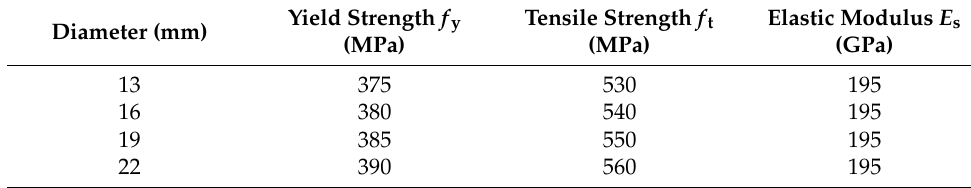
Table 4. Mechanical properties of studs.